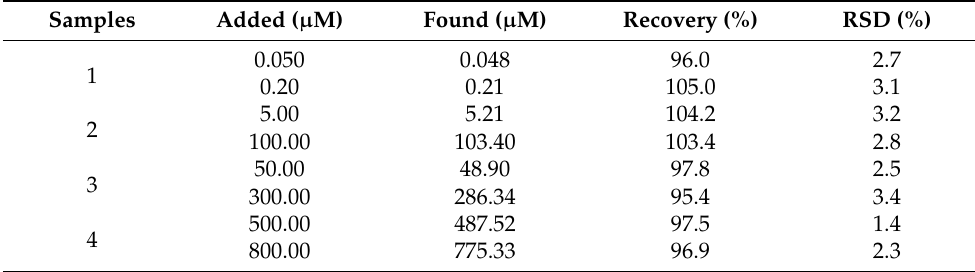
Table 3. Determination of DA in different serum